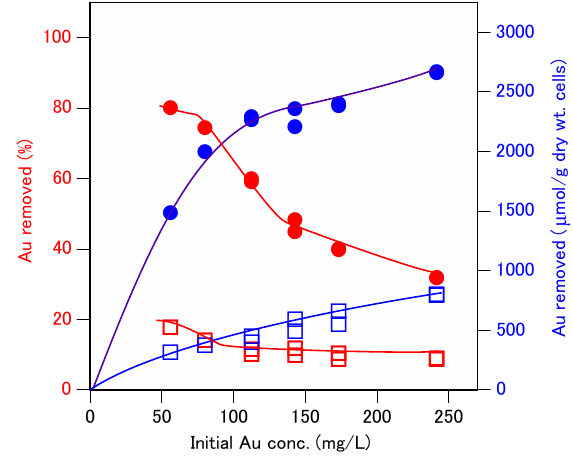
Figure 6. Effect of gold (III) concentration on gold removal by C. krusei AHU3993. Closed symbols: Au removed (%); open symbols: Au removed ( μ mol/g dry cell weight); circles: 72-h incubation (biomineralization); squares; 1-h incubation (biosorption).